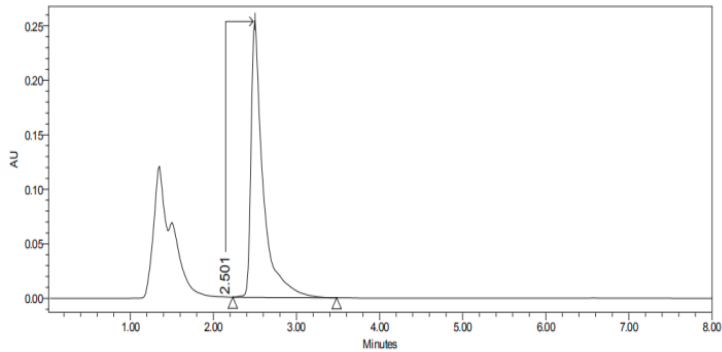
Figure 5. Chromatogram of CP-NPs in buccal mucous at 6 h.